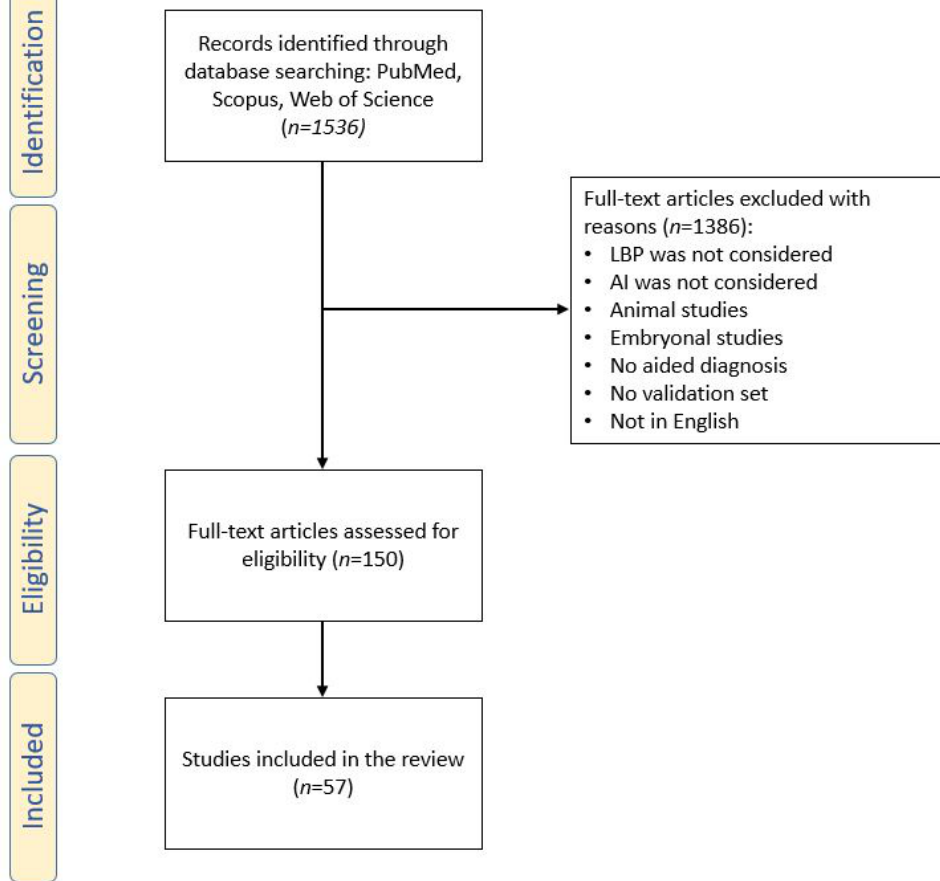
Figure 3. Preferred reporting items for systematic reviews and meta-analyses (PRISMA) flow